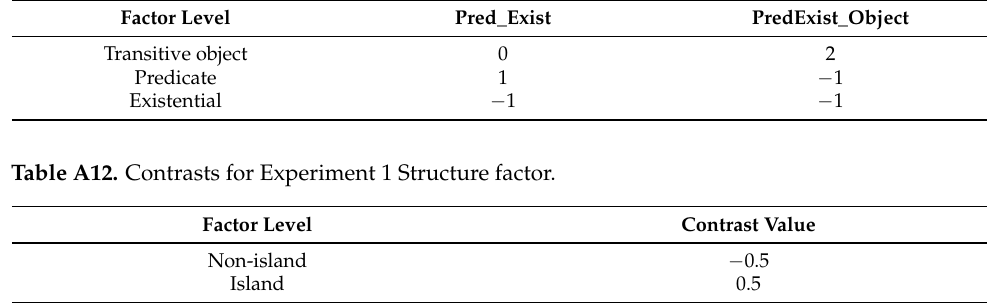
Table A11. Contrasts for Experiment 1 Environment factor (Helmert coding).